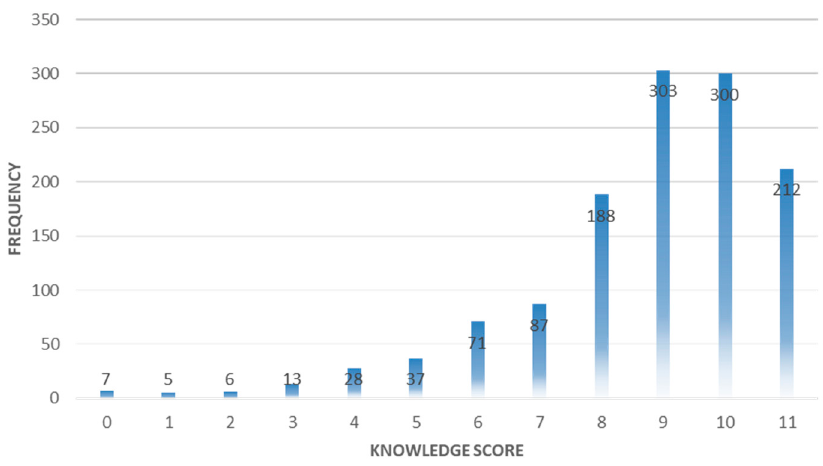
Figure 1. Knowledge score of the participants towards COVID-19. Table 3. Knowledge of the participants towards COVID-19 ( n